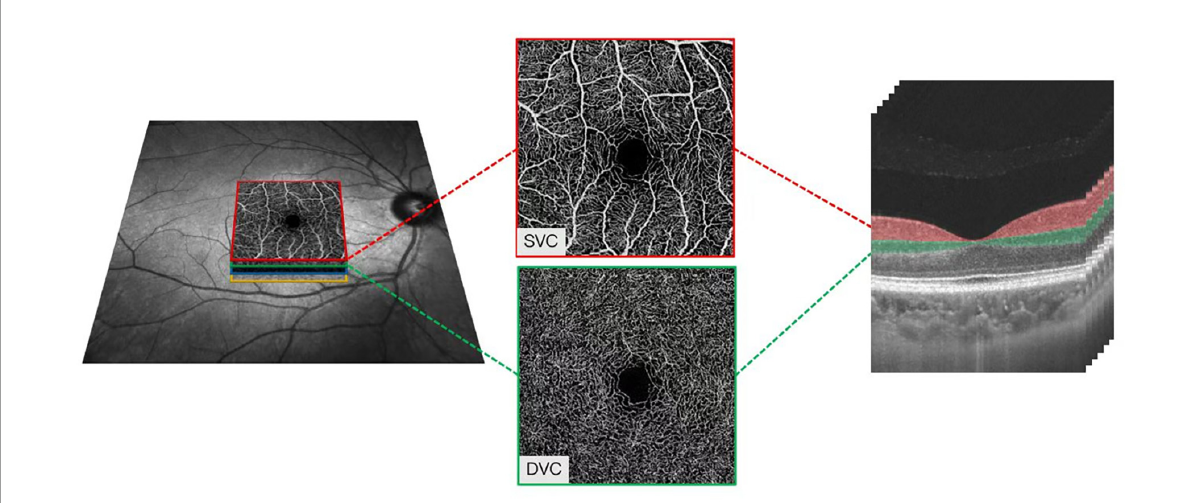
FIGURE1 Illustrative image of the macular microvasculature. The superficial vascular plexus (SVC) and deep vascular plexus (DVC), which was 5 µ m above the inner limiting membrane (ILM) to 25 µ m below the lower layer of the inner nuclear layer (INL).